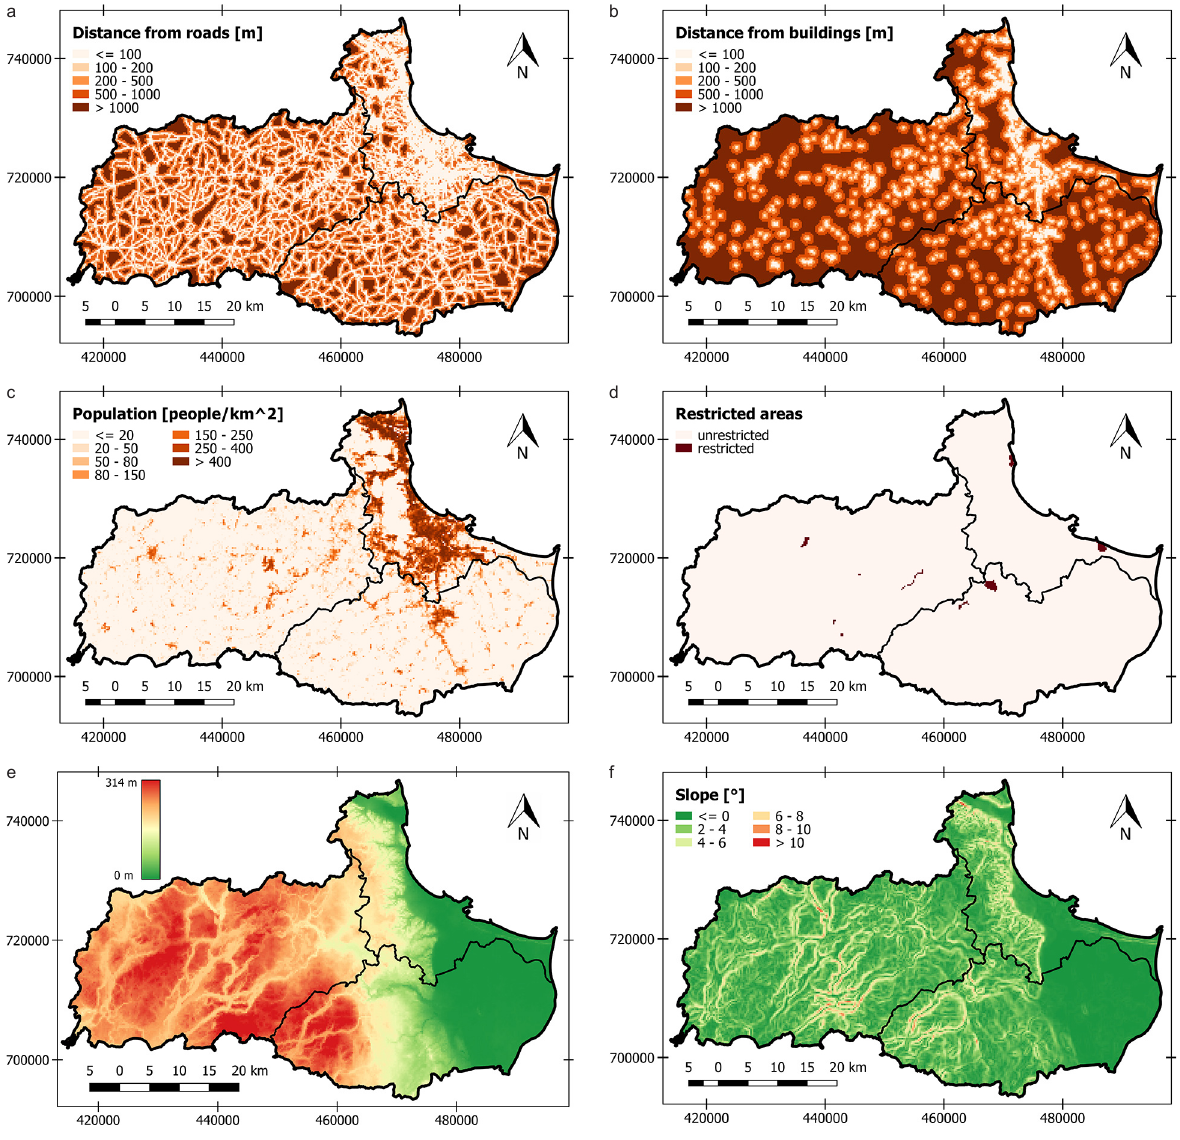
Fig. 3. Explanatory variables, raster data.